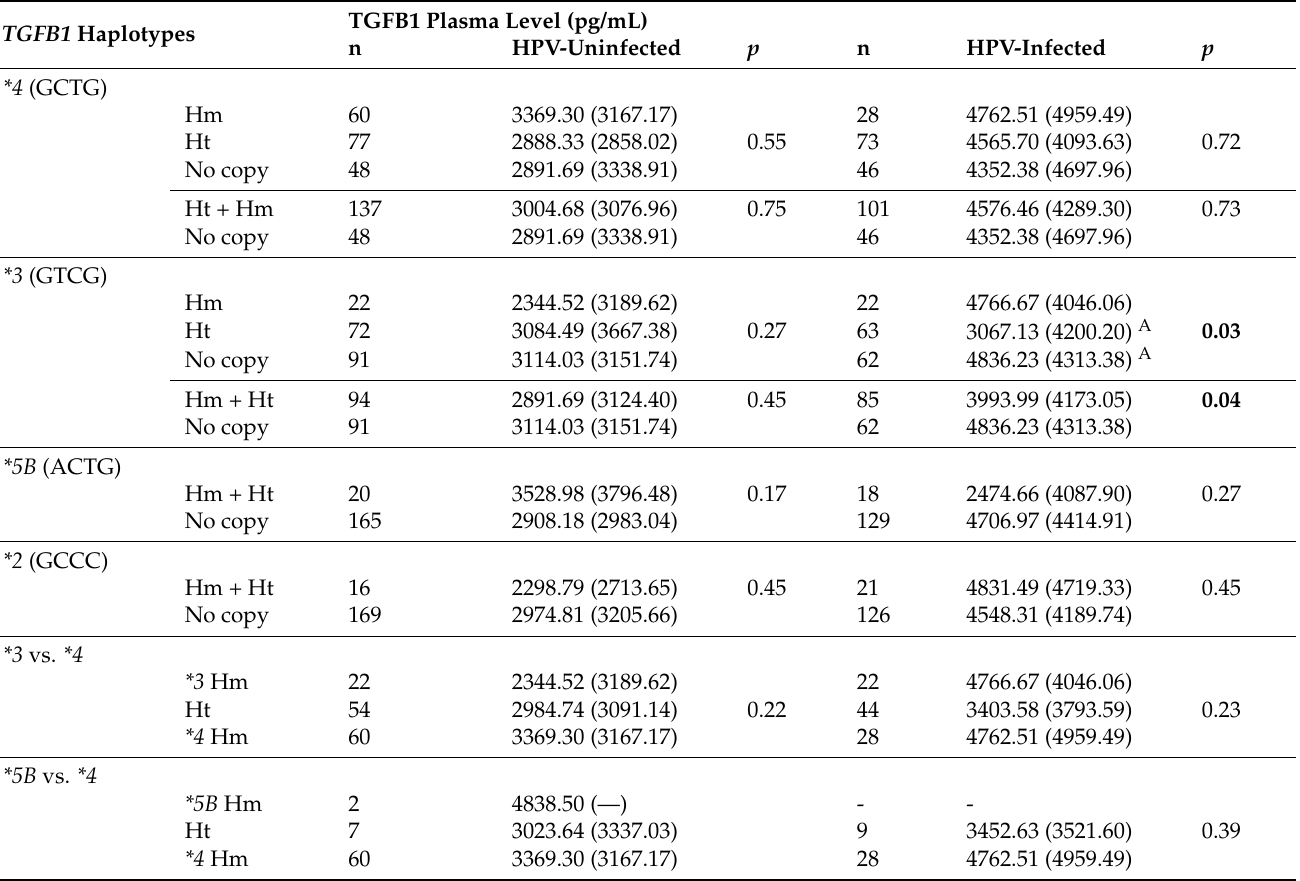
Table 5. Plasma level of TGFB1 according to TGFB1 haplotype models in uninfected and infected women.